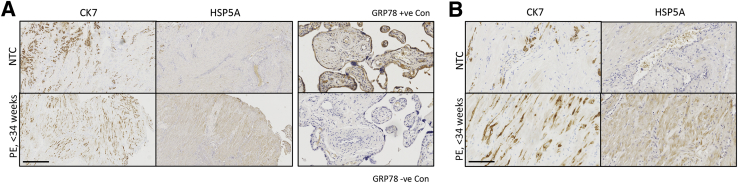
Endoplasmic reticulum (ER) stress is present in extravillous trophoblasts of placental bed samples from patients with preeclampsia (PE). Immunohistochemistry for the trophoblast marker cytokeratin 7 (CK7) and the ER stress biomarker heat shock 70-kDa protein 5 (HSPA5) [alias 78-kDa glucose regulated protein (GRP78)] was performed on serial sections from placental bed samples from both patients with PE and normotensive controls (NTCs) Placental villous tissue was used as a positive control for HSPA5 immunostaining. Scale bars: 500 μm (A); 100 μm (B). Original magnification: ×50 (A); ×200 (B).